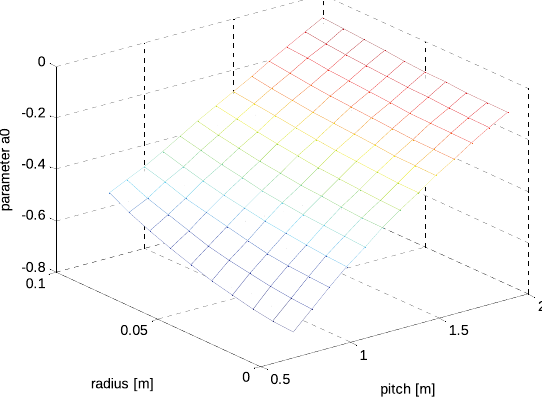
Figure 2. Parameter a 0 versus radius α and pitch p of the helix.